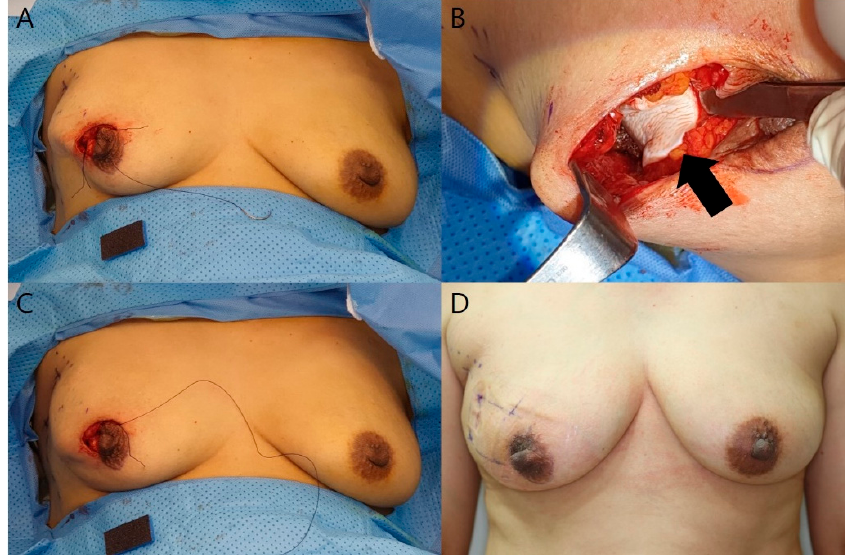
Figure 2. Intra- and postoperative photographs of a 52-year-old woman. The tumor is located in the upper outer quadrant of the right breast. The resected breast tissue was 50 g, and 2 sheets of ADM were used. ( A ) Intraoperative photograph after local tissue rearrangement. IMF retraction is also observed; ( B ) After the rearrangement is released, an ADM graft is placed on the pectoralis major muscle. The black arrow indicates the ADM; ( C ) After ADM graft placement, the IMF retraction disappears, and the breast volume is maintained; ( D ) Postoperative photographs after 1 month. The breast contour is maintained without any deformity.